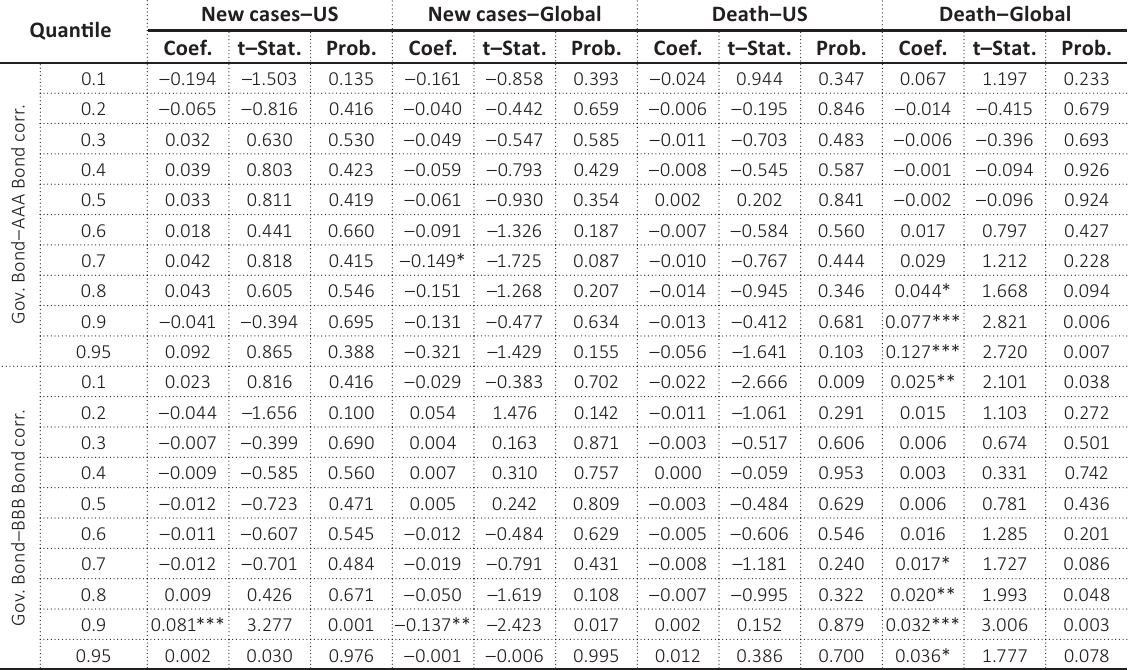
Table 2. Summary of QR estimates